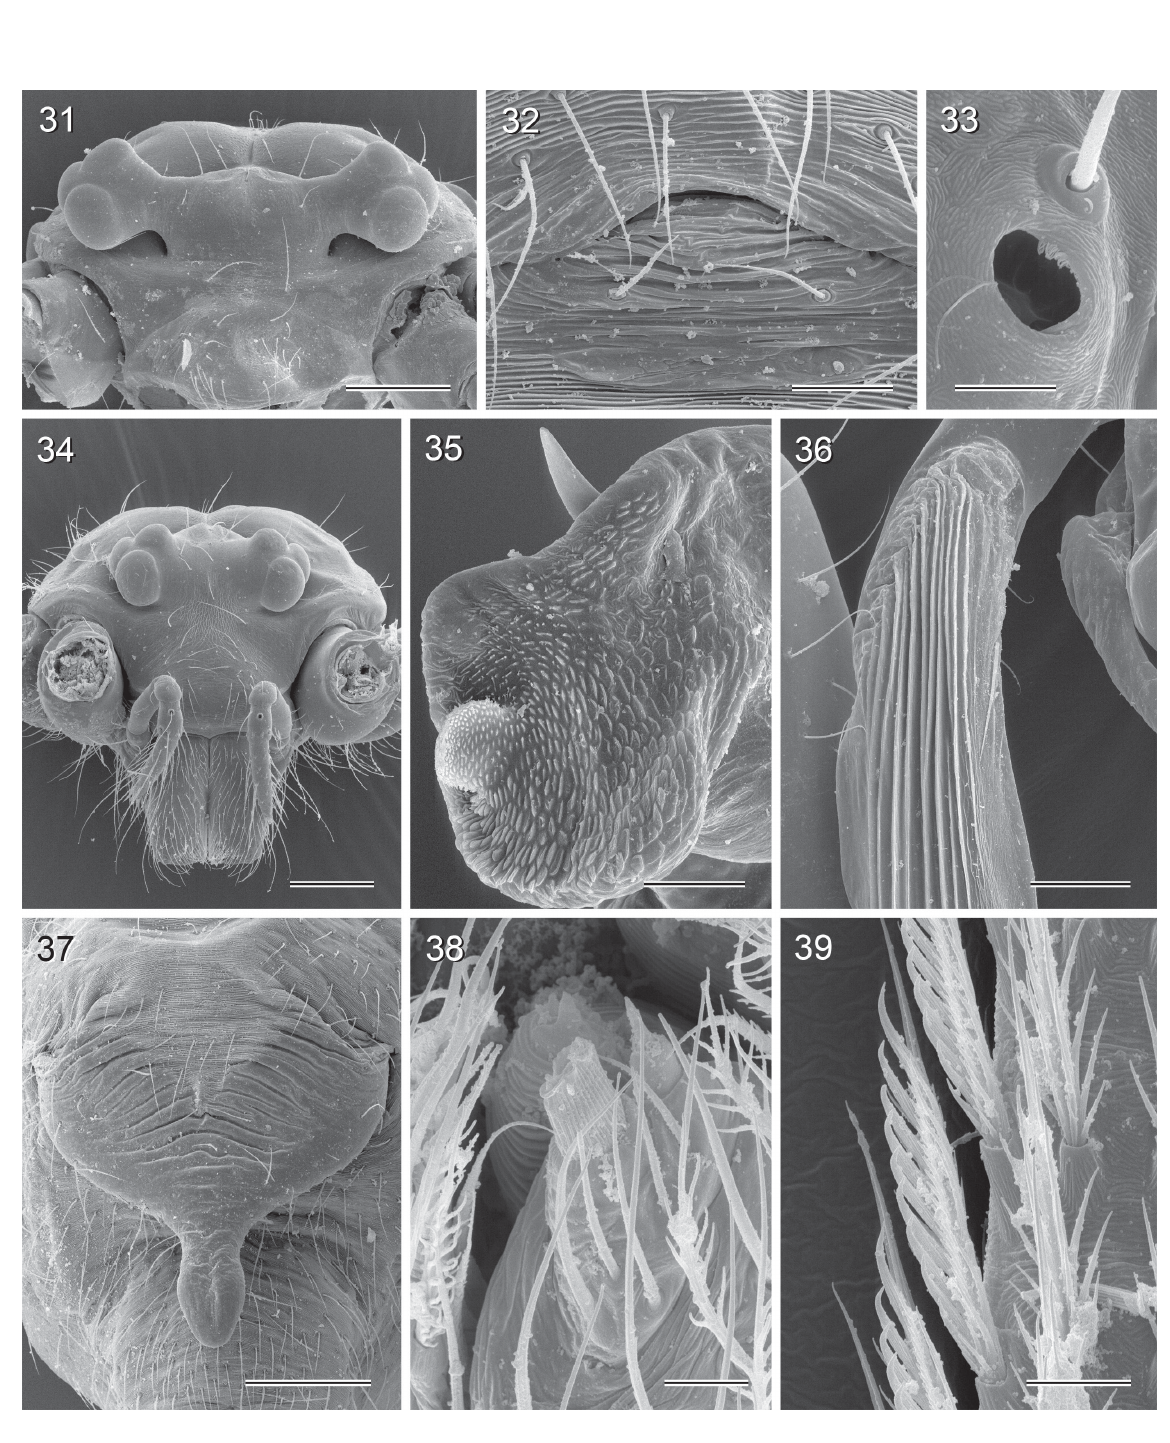
Figs 31–39. Hantu niah gen. et sp. nov., ZFMK Ar 15072–73. 31 . Male prosoma, anterior view. 32 . Male gonopore. 33 . Male palpal tarsal organ. 34 . Female prosoma, frontal view. 35 . Tip of right procursus, retrolateral view. 36 . Lamellae of left procursus, prolateral view. 37 . Epigynum, ventral view. 38 . Male ALS. 39 . Comb-hairs on male tarsus 4. Scale lines: 8 µm (33); 10 µm (38–39); 30 µm (32, 35); 80 µm (36); 200 µm (31, 34,